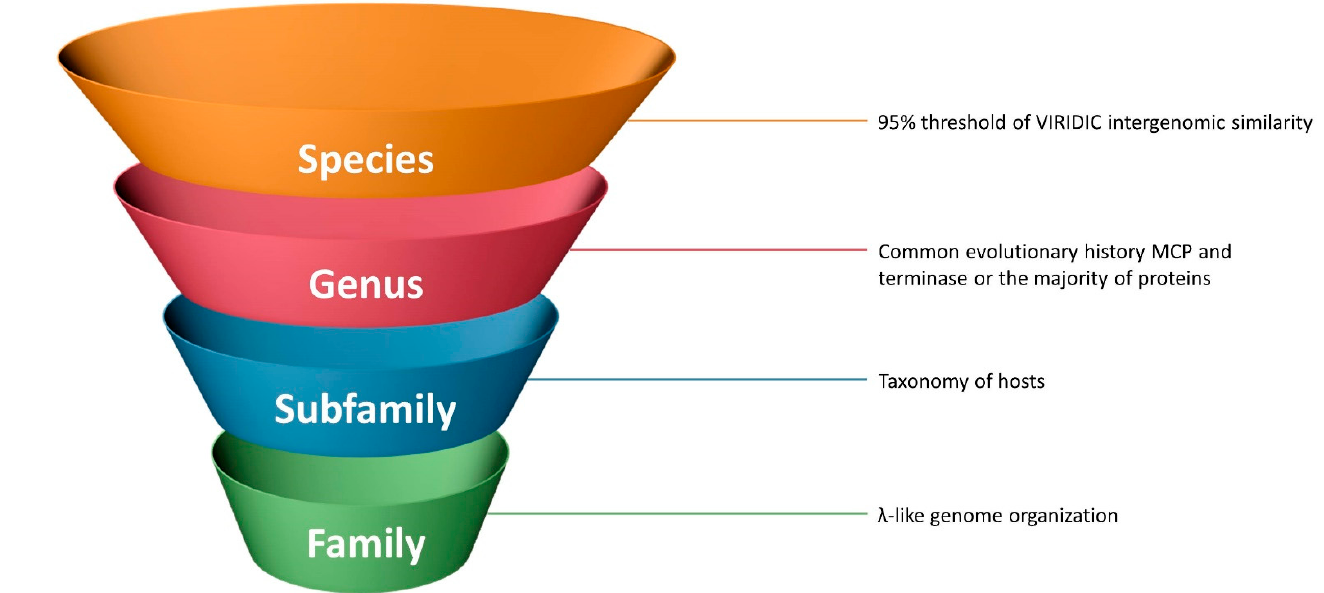
Figure 12. Possible criteria for the taxonomic classification of lambdoid bacteriophages.